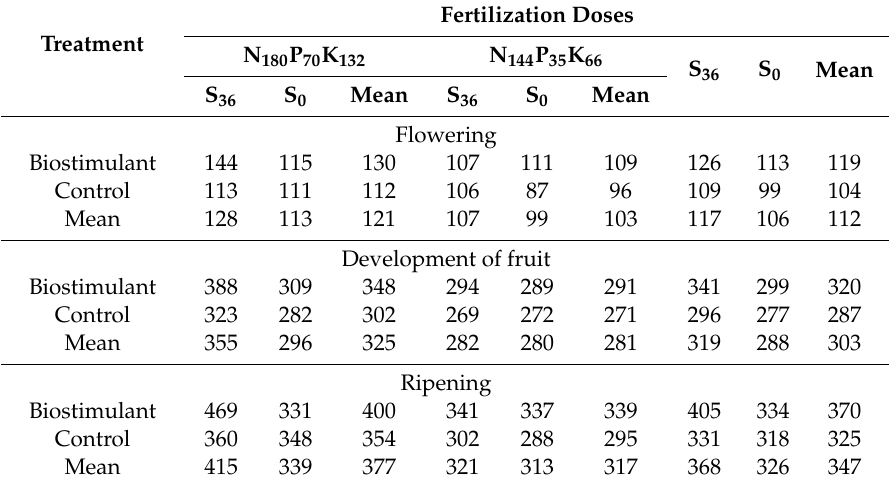
Table 7. Accumulation of K in shoots of rapeseed in generative development stages depending on